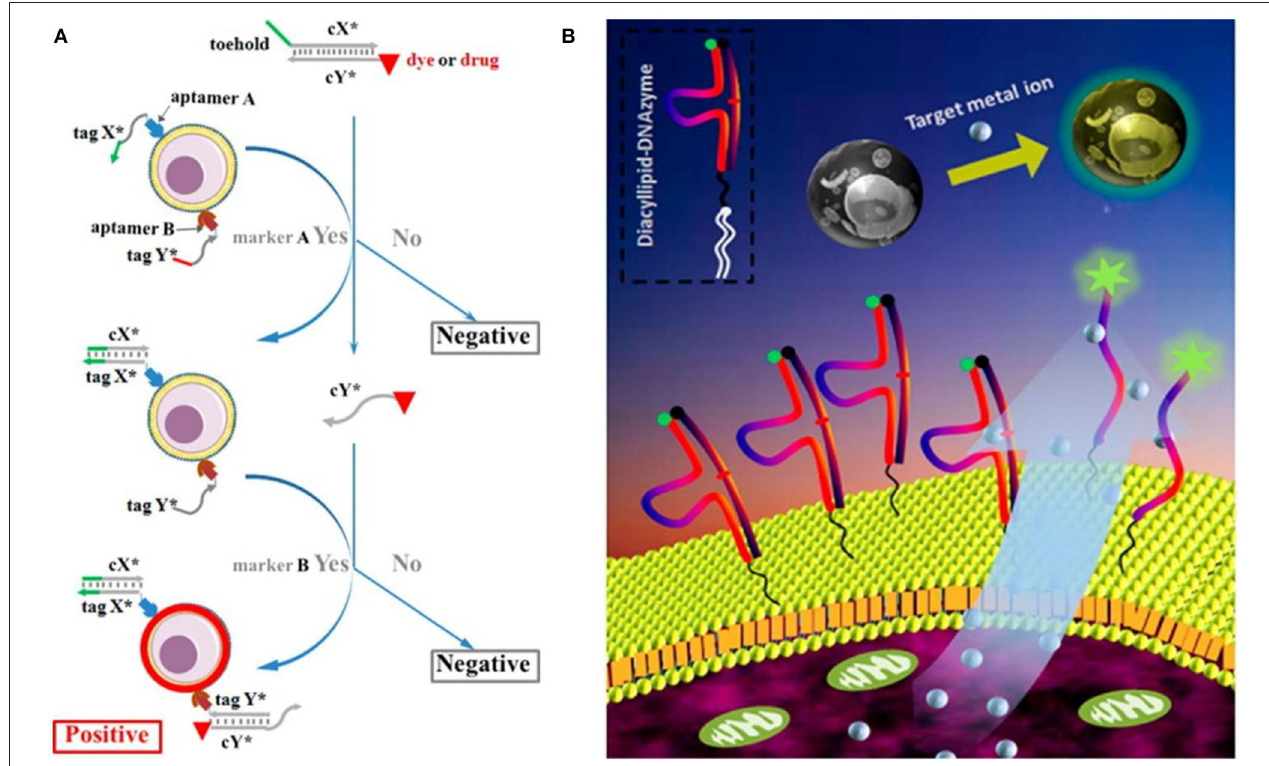
FIGURE 1 | (A) Scheme of DNA-based logic platform for multiparameter cancer cell recognition (You et al., 2015); (B) Scheme of diacyllipid-conjuageted DNAzyme fluorescence probe ( Qiu et al., 2014). Reproduced with the permission of American Chemical Society.